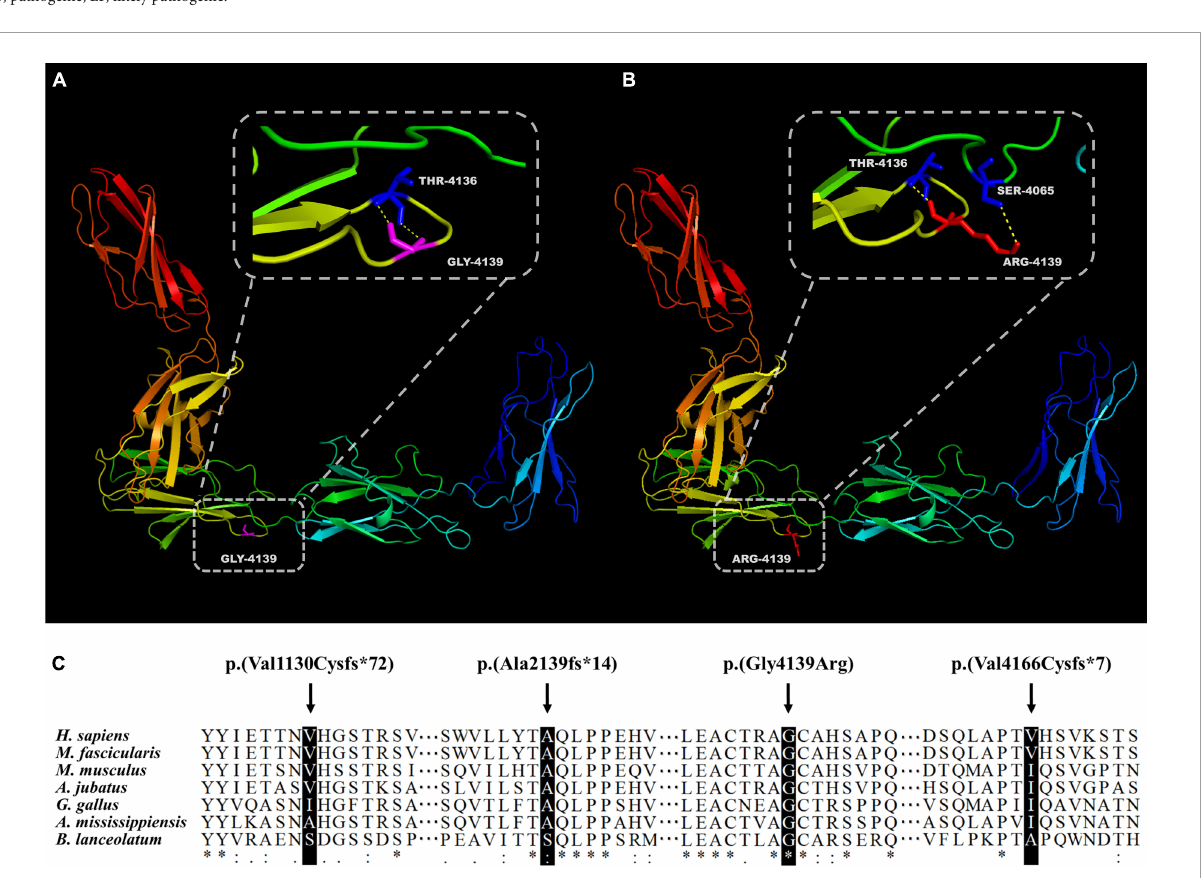
FIGURE3 Evaluation of novel mutations in USH2A . Presentation of five adjacent FN3 domains and residue 4139 in wildtype (A) and mutant (B) usherin. (C) Alignment of the usherin protein sequence of residues 1130, 2139, 4139, and 4166 to its orthologous protein sequences in different species. The asterisk “*” indicates positions with a single and fully conserved residue, colon “:” indicates highly conserved positions, and “.” indicates positions with a weak